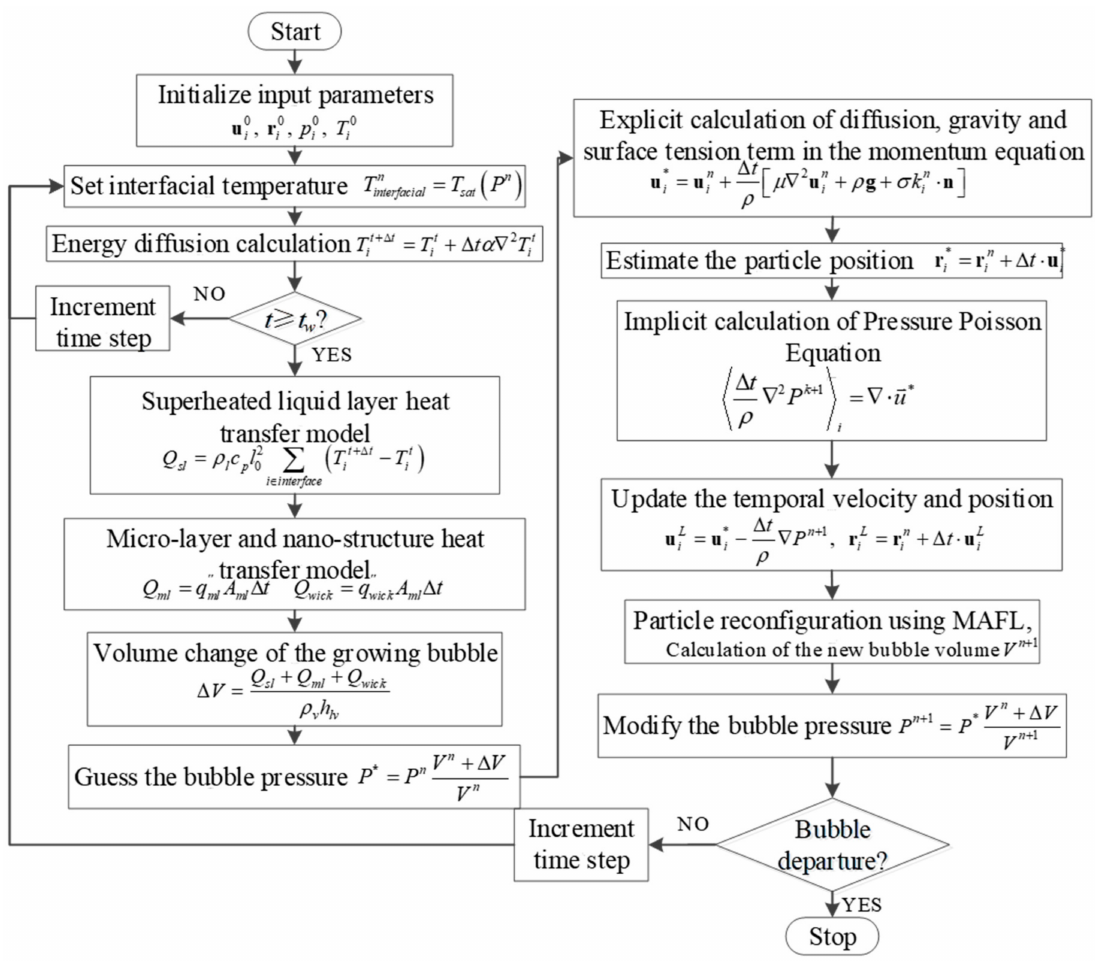
Figure 7. The calculation